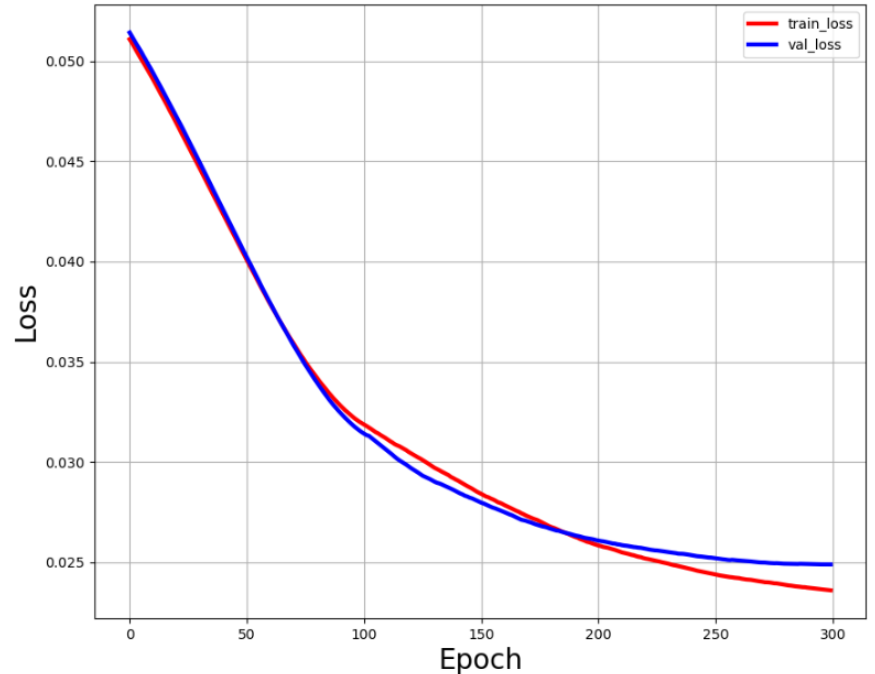
Figure 6. Training and validation loss curves for our network. The red line and the blue line represent